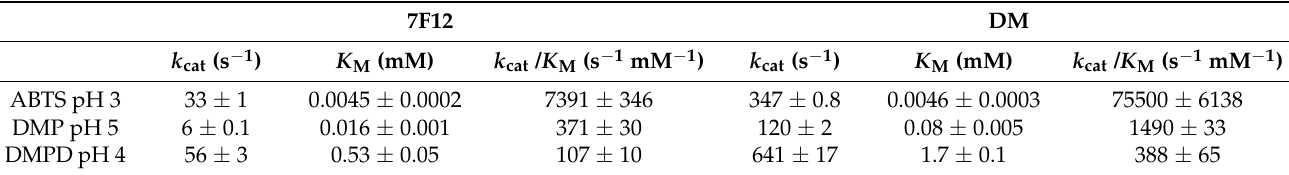
Table 4. Kinetic constants for oxidation of model substrates by 7F12 and DM laccase variants.